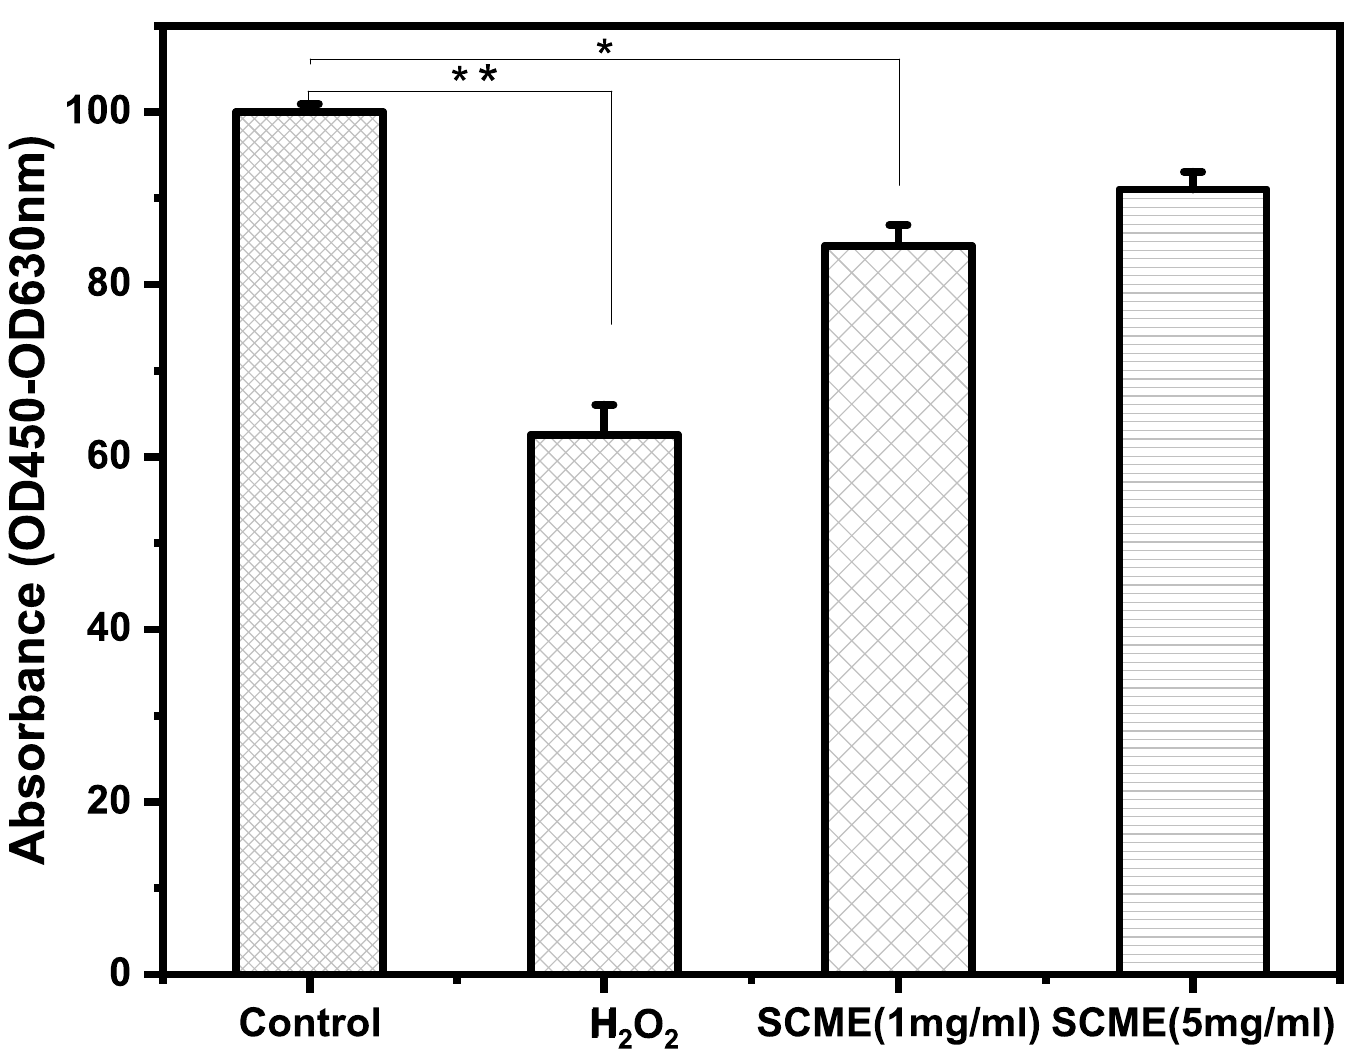
Fig 4. Cytotoxicity evaluation of S . cumini leaves extract by XTT assay on bone marrow derived mesenchymal stem cells (BM-MSCs). Cells were treated with plant extract at concentration of 1 mg/ml and 5 mg/ml for 24 h. S . cumini leaves extracts showed significant cytoprotective activity at increased dose of extract. Data is expressed as Mean ± SEM (n =